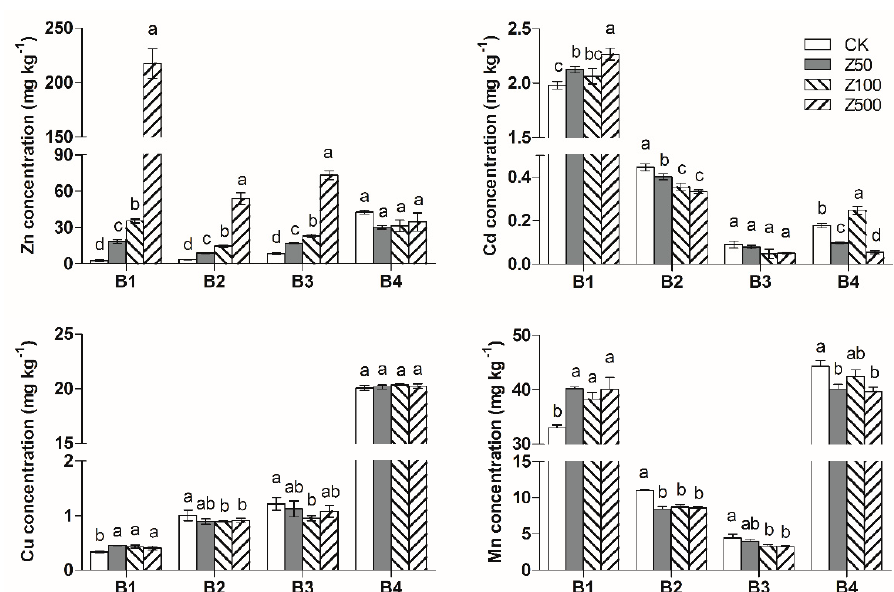
Figure 3. Changes in soil heavy metals chemical speciation with ZnO-NPs addition. B1: acid-soluble fraction; B2: Fe/Mn oxides-bound fraction; B3: organic-bound fraction; B4: residual fraction. Different letters above each column indicate significant difference ( p < 0.05) between various treatments.